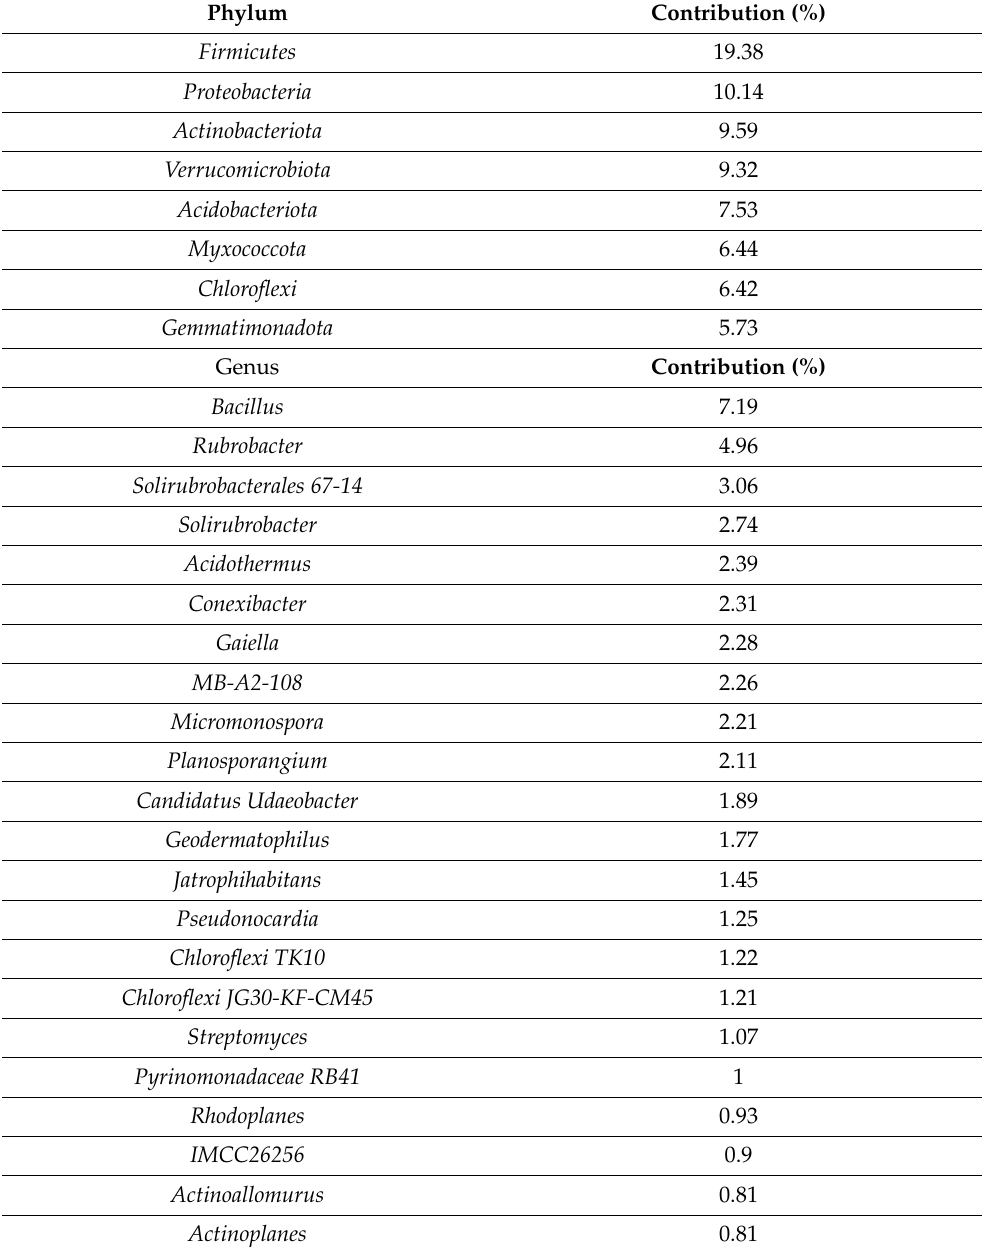
Table 2. Phyla and known genera with the highest contribution to CTR–PHY group